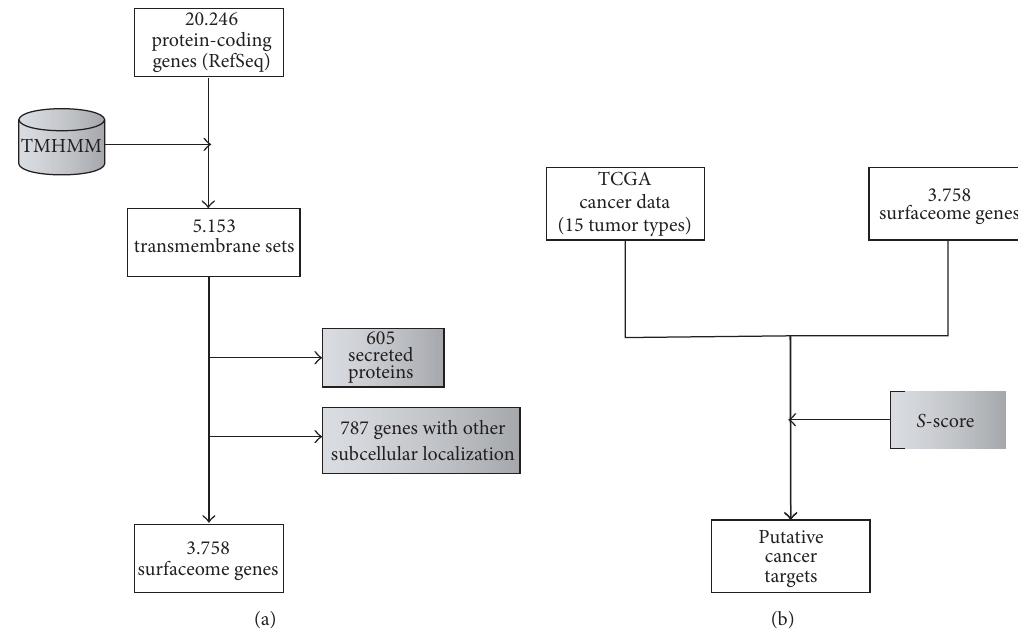
Figure 1: Methodology workflow. (a) The NCBI RefSeq dataset was submitted to TMHMM and selected for the presence of a transmembrane domain. Proteins containing only a signal peptide (classified as secreted) or belonging exclusively to other membranes were excluded, giving a final set of 3.758 genes coding for cell surface proteins. (b) TCGA data as used to calculate the 𝑆 -score for the surfaceome set allowing the identification of putative surfaceome cancer